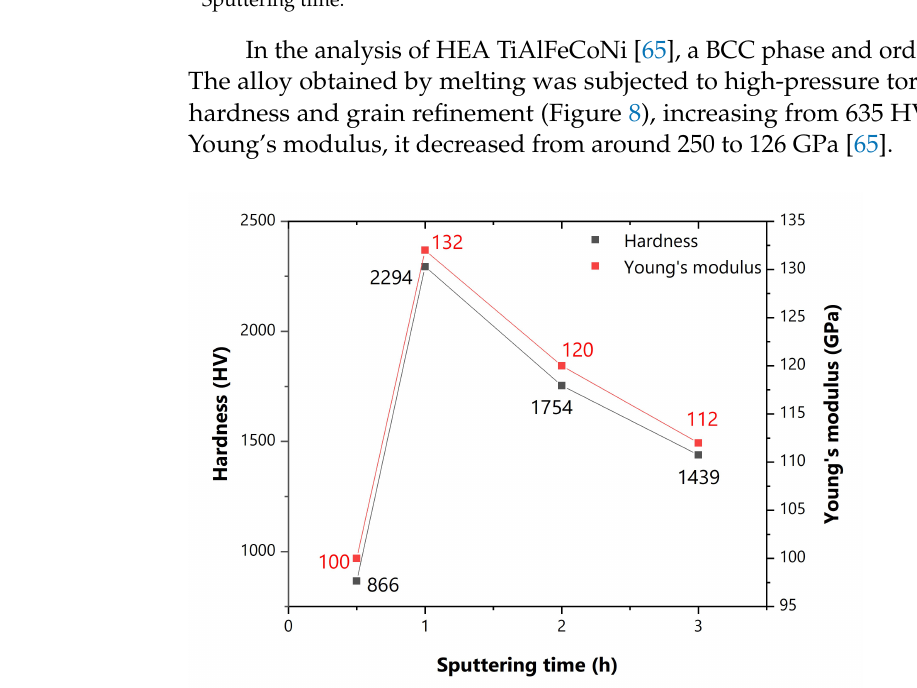
Figure 7. Evolution of hardness and Young’s modulus as a function of sputtering time of the FeCoNiTiAl coating. Based on